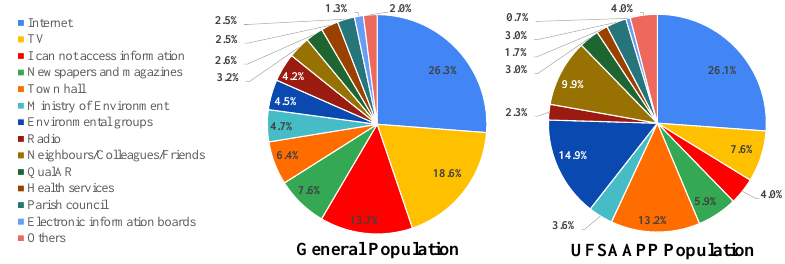
Figure 9. Sources of information about air quality for general and UFSAAPP populations.